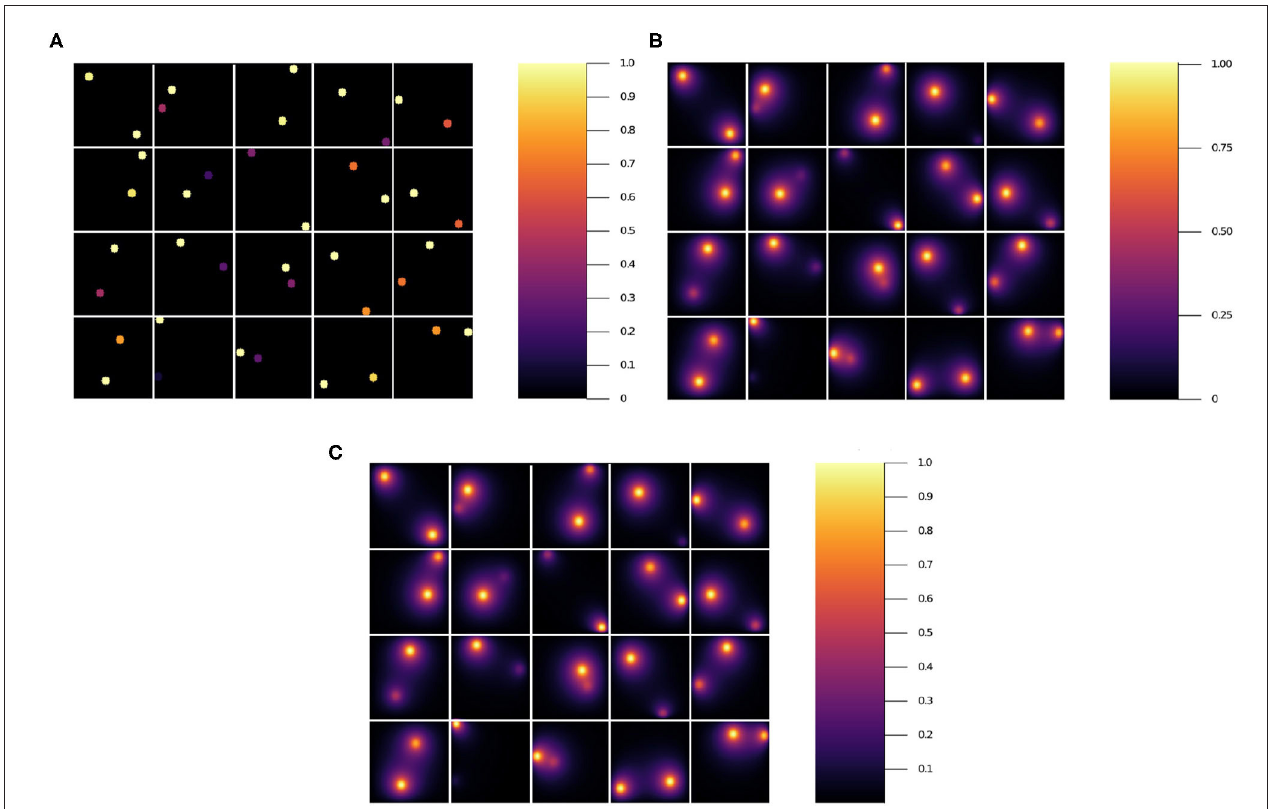
FIGURE 5 | Results for 20 randomly selected test data sets’. (A) input, (B) ground truth (target output), and (C) NN surrogate prediction of steady-state diffusion field output for the